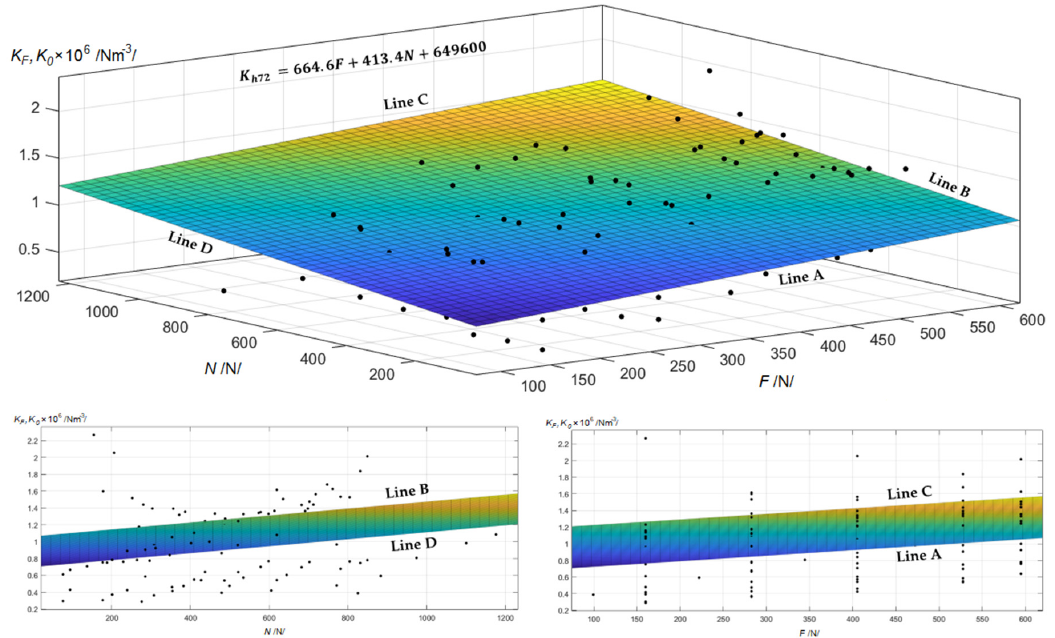
Figure 10. Approximated data with a linear function K h 72 = function ( F , N ) /Nm − 3 / for wheat layer thickness h = 72 mm.